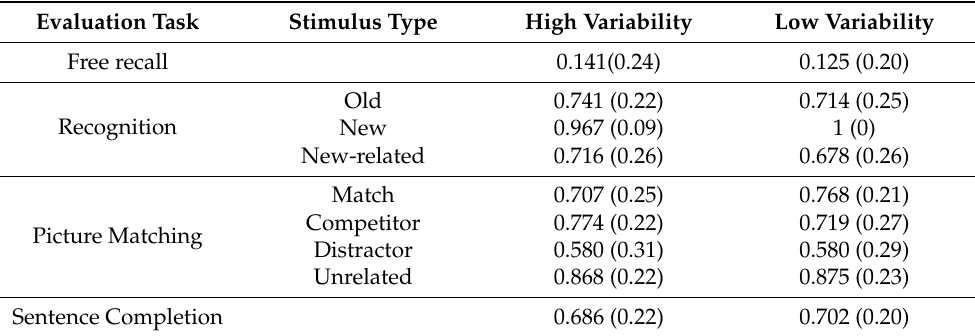
Table 1. Mean accuracy (proportion of correct responses) across conditions in the four experimental tasks. Standard deviations are provided in